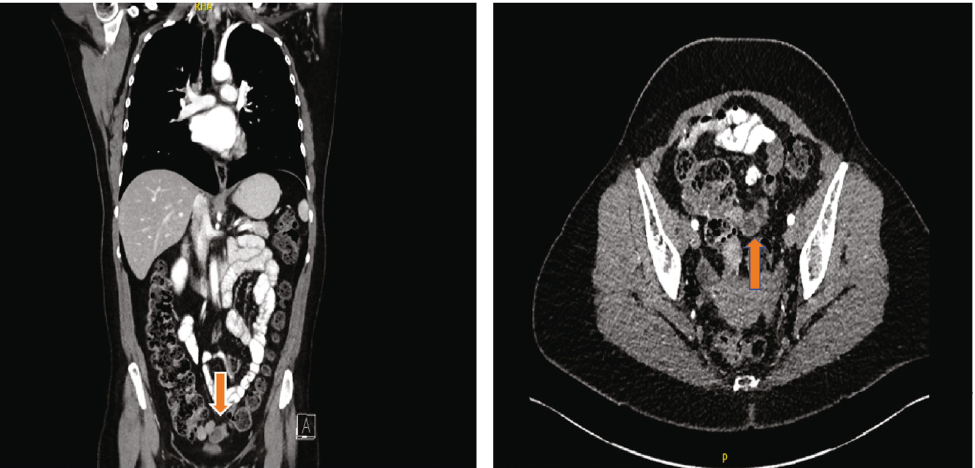
Figure 1: Coronal and cross-sectional views of computerized topography imaging demonstrating the appendiceal